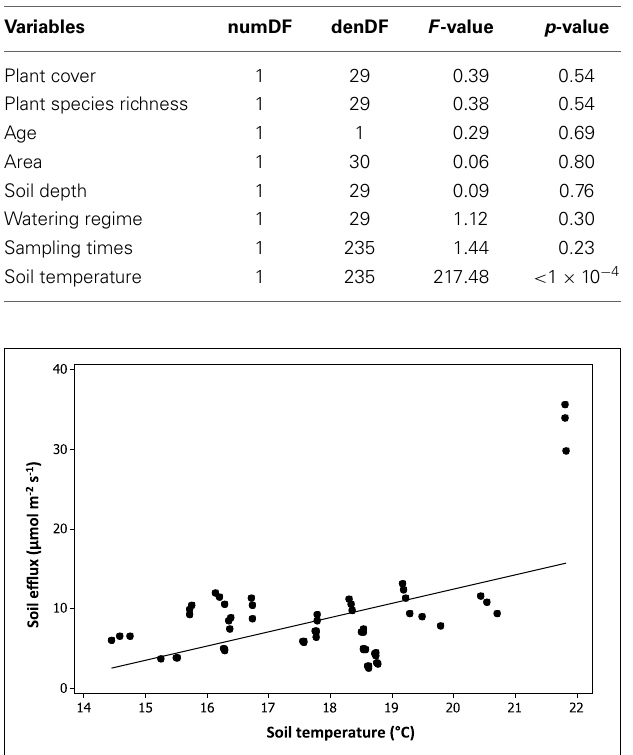
Table 4 | Results from a Wald test of a linear mixed effect model with the response variable soil CO 2 respiration to assess the significance of the fixed effects (i.e., PAR, sampling times, water regime, planter depth, planter area, establishment age, soil arthropod species richness, soil arthropod species abundance, plant species richness, and plant coverage) on a linear mixed effects model for soil CO 2 respiration.